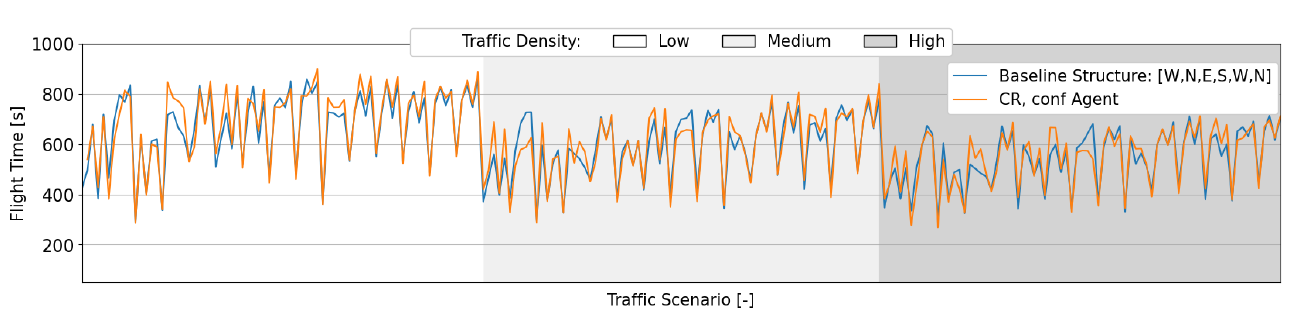
Figure 22. Flight path per aircraft. All traffic densities had 75 traffic scenarios, with the initial direction(s) and the number of turns following the same order as shown during the training phase.